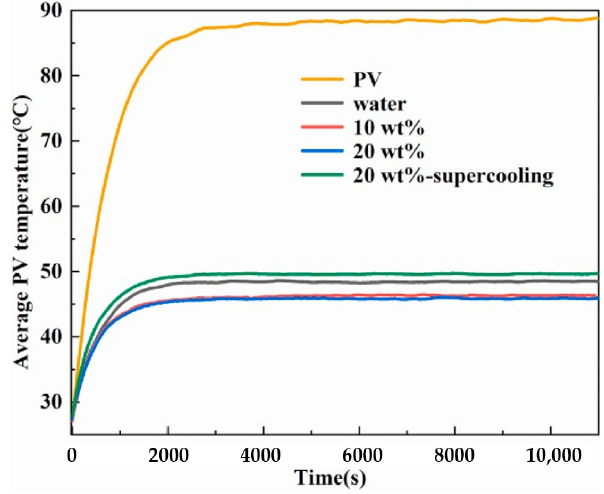
Figure 13. Average surface temperature of PV module at a flow rate of 10 L/h and a constant inlet temperature of 30 °C ( Reproduced with permission from Ref. [127]. Copyright 2021 Elsevier).